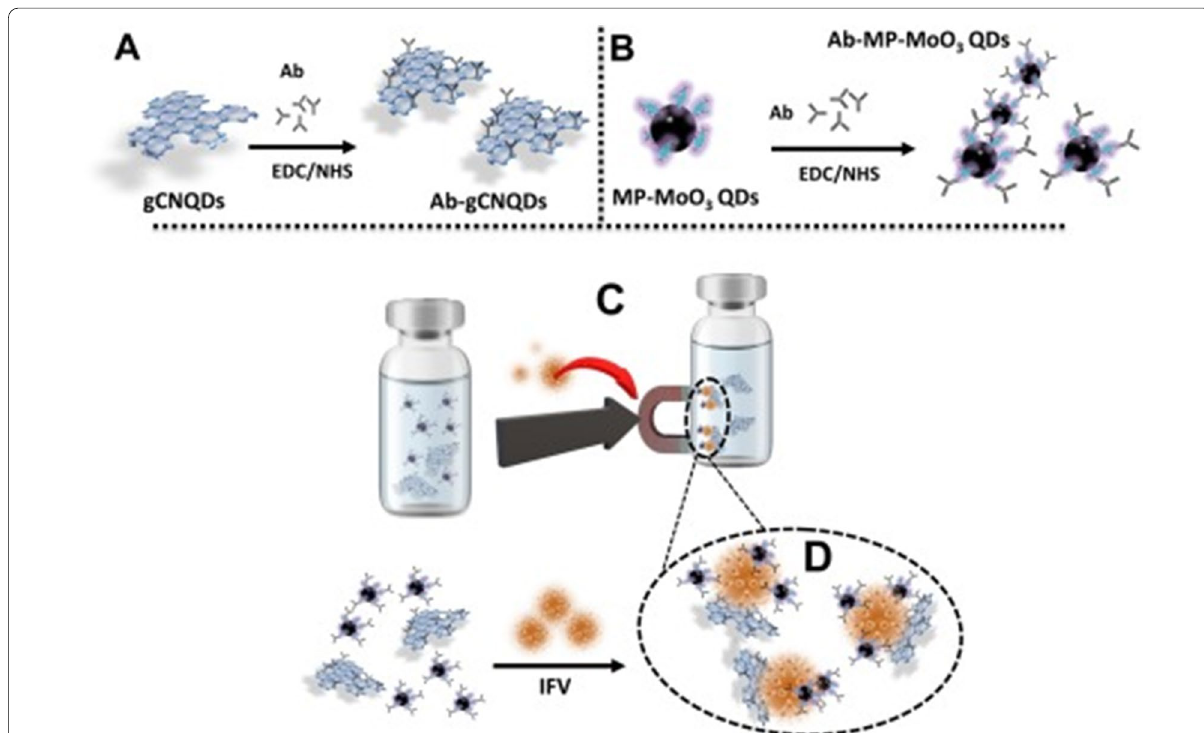
Fig. 6 A Antibody conjugation to CQDs via covalent chemistry. B Antibody conjugation to MP-MoO 3 QDs via covalent chemistry. C Magnetic separation and purification step upon target virus addition. D Core-satellite immunocomplex of CQDs and MP-MoO 3 QDs in the presence of influenza virus [177]. Reproduced with permission. Copyright © 2020 Elsevier